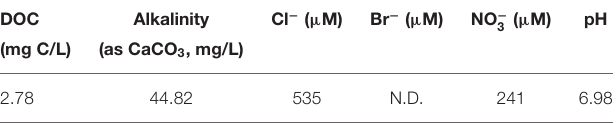
TABLE 5 | Water quality parameters of tap